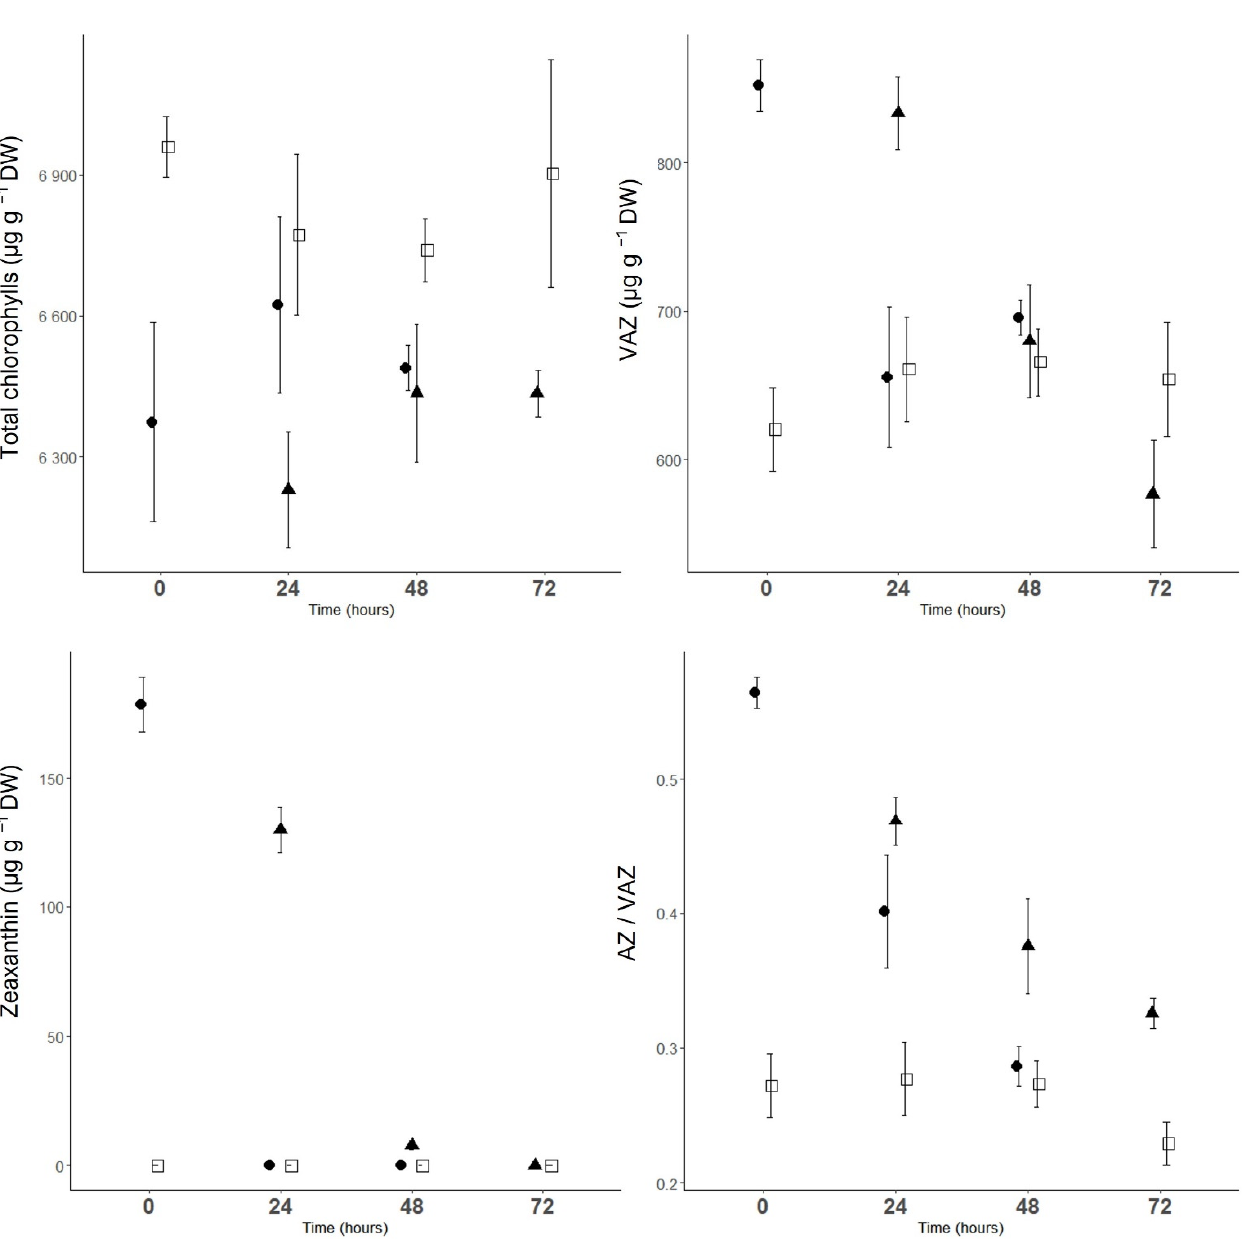
Figure 3. The content of total chlorophylls, VAZ (xanthophyll cycle pigments) and zeaxanthin and AZ/VAZ ratio (de-epoxidation state of xanthophyll cycle pool) in sweet cherry leaf, at time 0, time 24, time 48 and time 72. ● , CT1 (one cold night exposure); ▲ , CT2 (two cold night exposures) and □ , C (control trees). Vertical bars represent ± SE of the mean ( n = 3; n = 3 and 6 for controls).